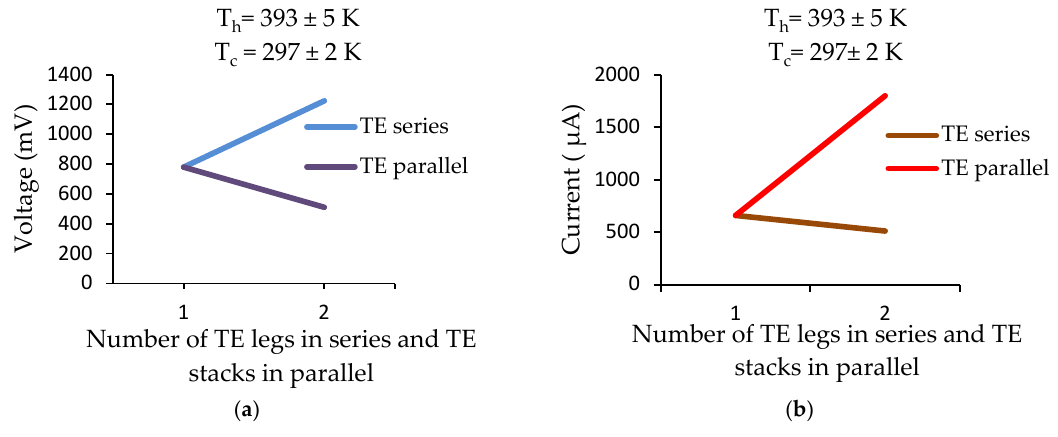
Figure 5. ( a ) The output voltage of the thermoelectric generator for serial and parallel connection; ( b ) the output current of the thermoelectric generator for serial and parallel connection.